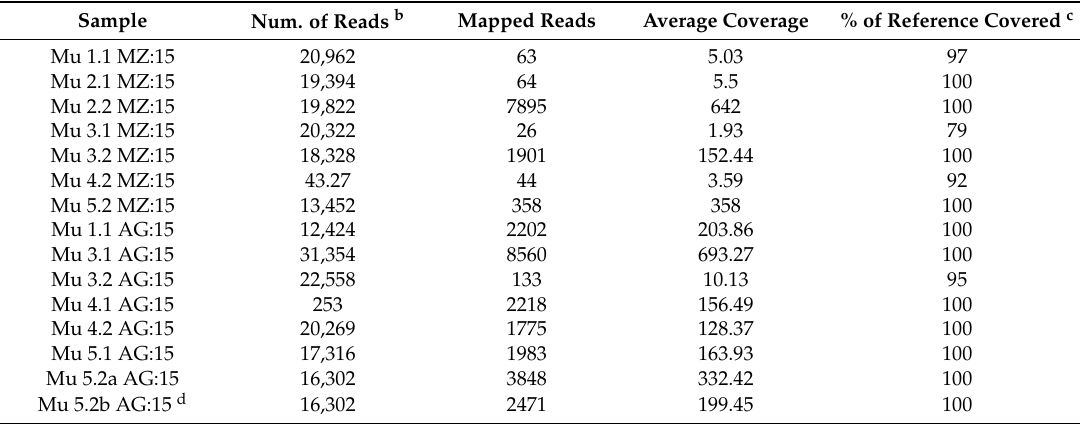
Table A1. HTS results summary for samples collected in 2015 a